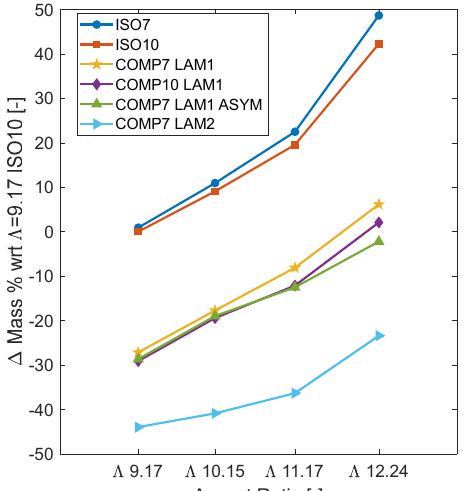
Figure 13. Relative wingbox mass variation with respect to ISO10 Λ = 9.17 solution vs. Λ .